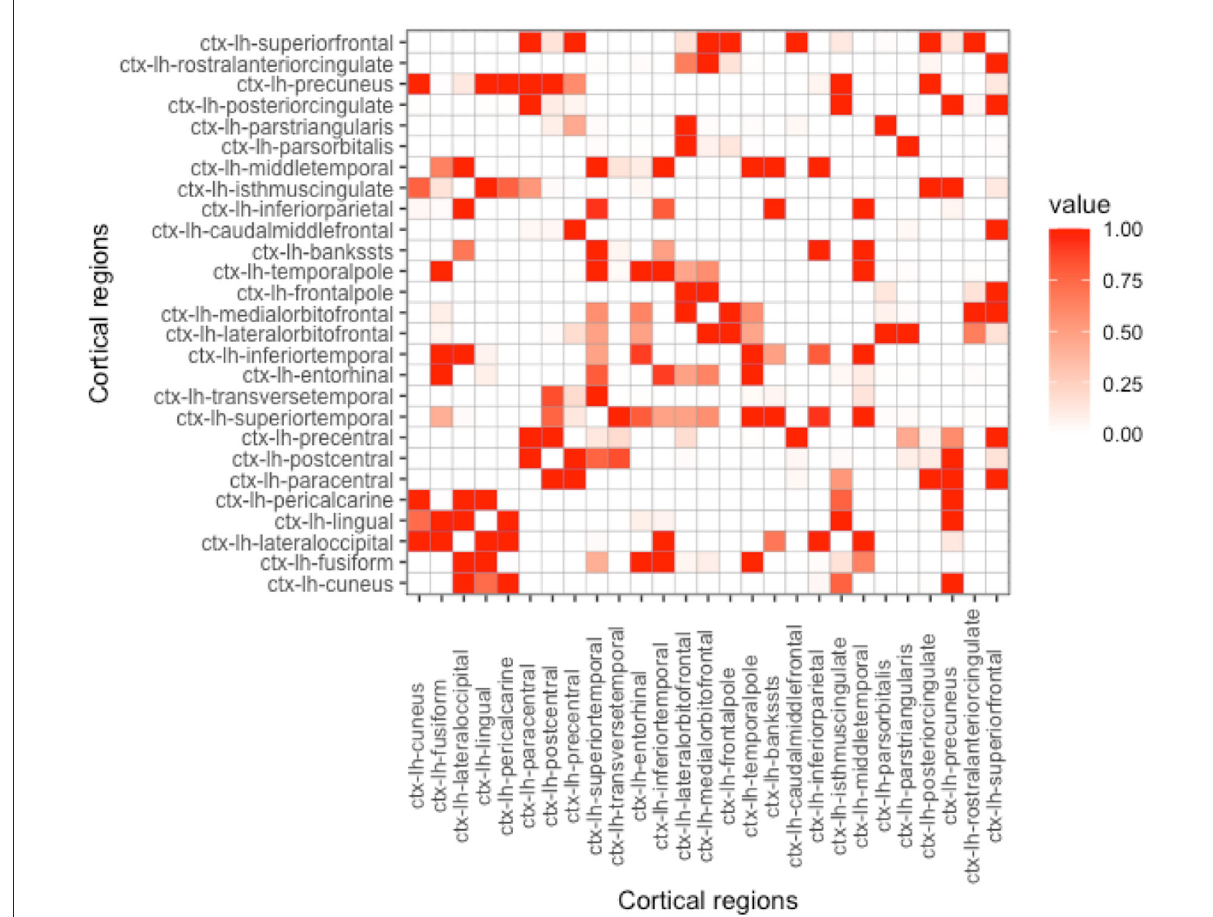
FIGURE5 Proximity matrix displayed for the left hemisphere, geodesic distance, and parameter h in the Supplementary